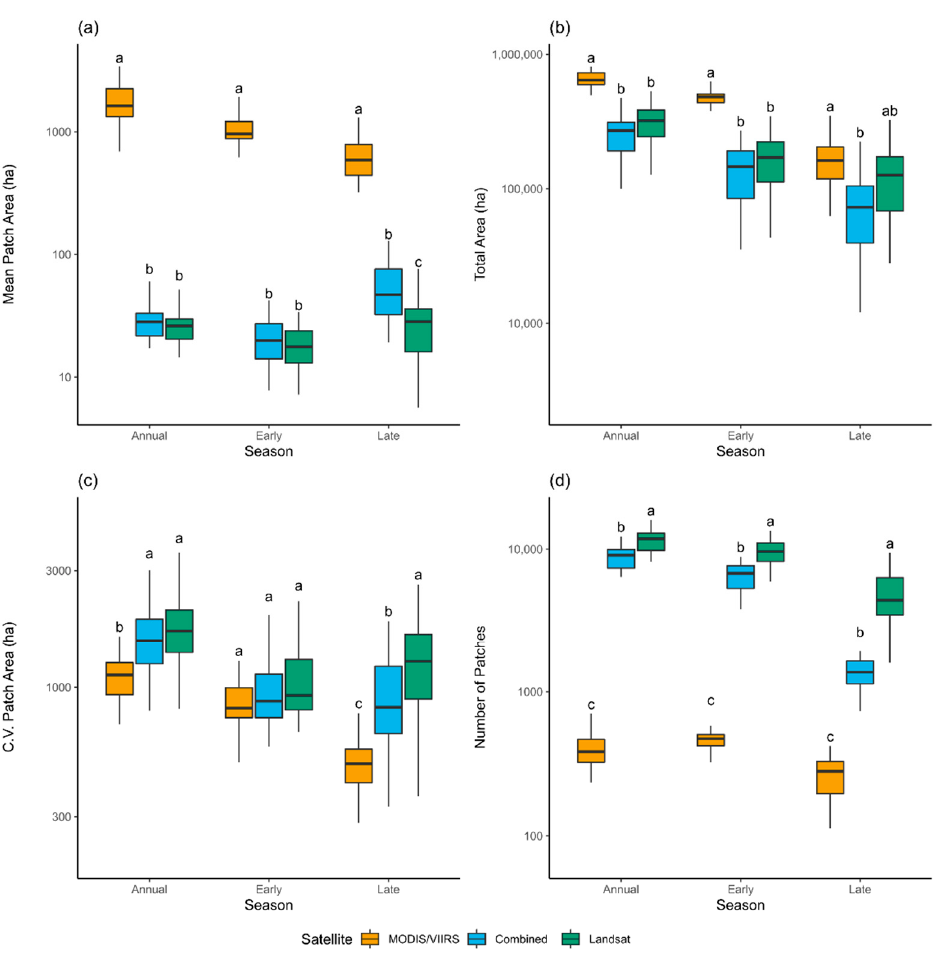
Figure 4. Boxplots of landscape metrics of area burned across the full record (2000–2021) in the lowland Eucalyptus savannas of Kakadu National Park based on Landsat, MODIS/VIIRS, and the combined Landsat-MODIS/VIIRS method, showing ( a ) mean area of patches, ( b ) total area burned, ( c ) coefficient of variation in patch area and ( d ) the number of patches. Box extents indicate 25th and 75th percentiles, with centre lines showing the median value, and whiskers indicating the most extreme values up to 1.5 times the interquartile range. Letters indicate pairwise differences within seasons and between satellites according to a Tukey–HSD test and one-way ANOVA on log-transformed values.